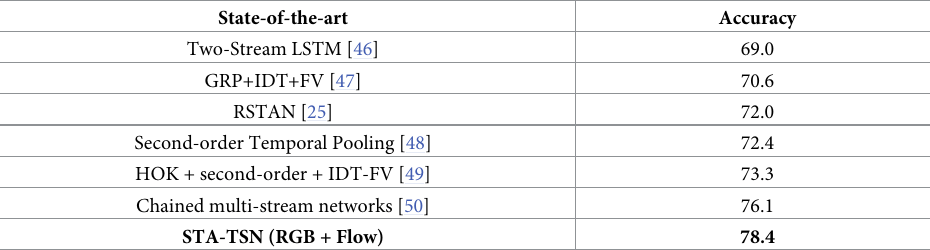
Table 6. Comparison with the state-of-the-art on JHMDB (average over three